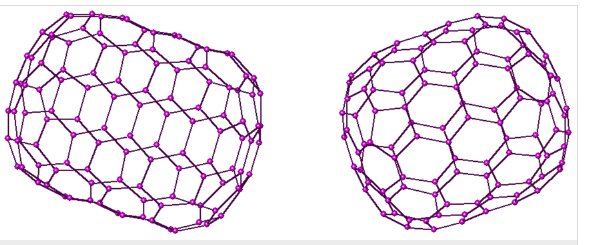
Figure 2: The 3D view of fullerenes C 108 (left) and C 96